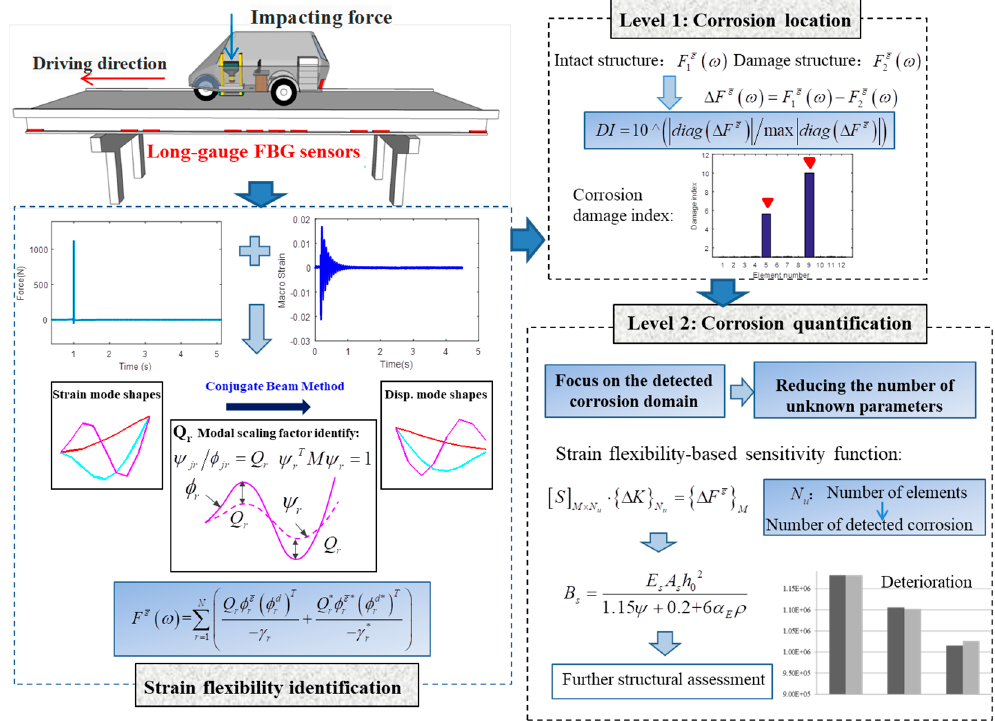
Figure 2. Framework of the proposed method.